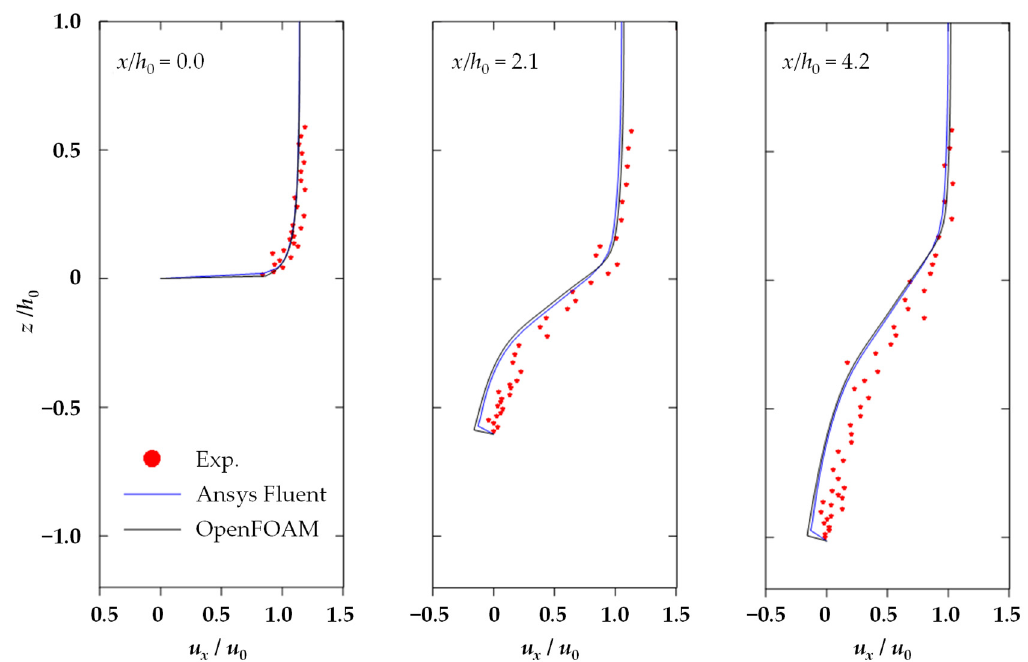
Figure 7. Comparison of velocity profile results of laboratory experiment, OpenFOAM, and Ansys Fluent at different downstream distances.